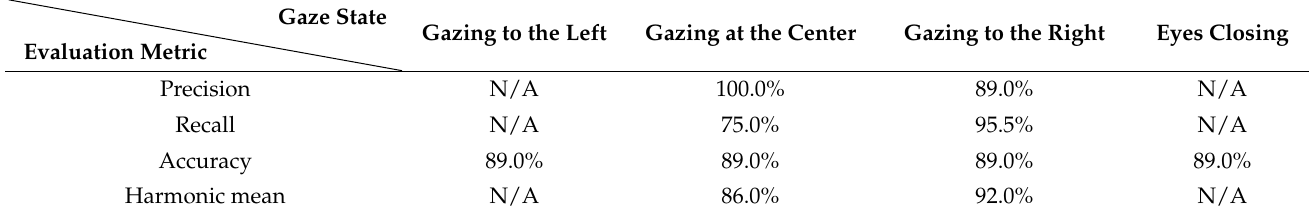
Table 6. Evaluation data of the eye gazing recognition results of the elderly man. Gaze State